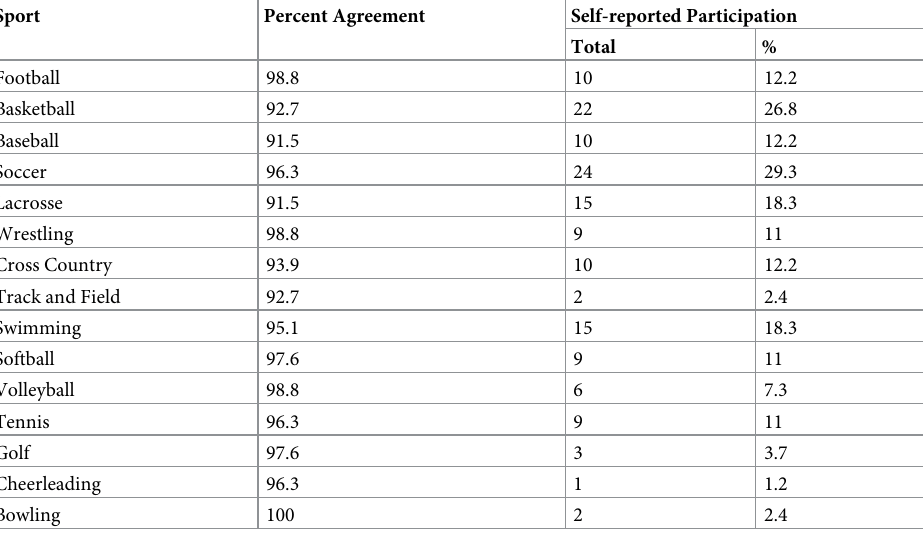
Table 1. Percent agreement and internal consistency for survey responses and school